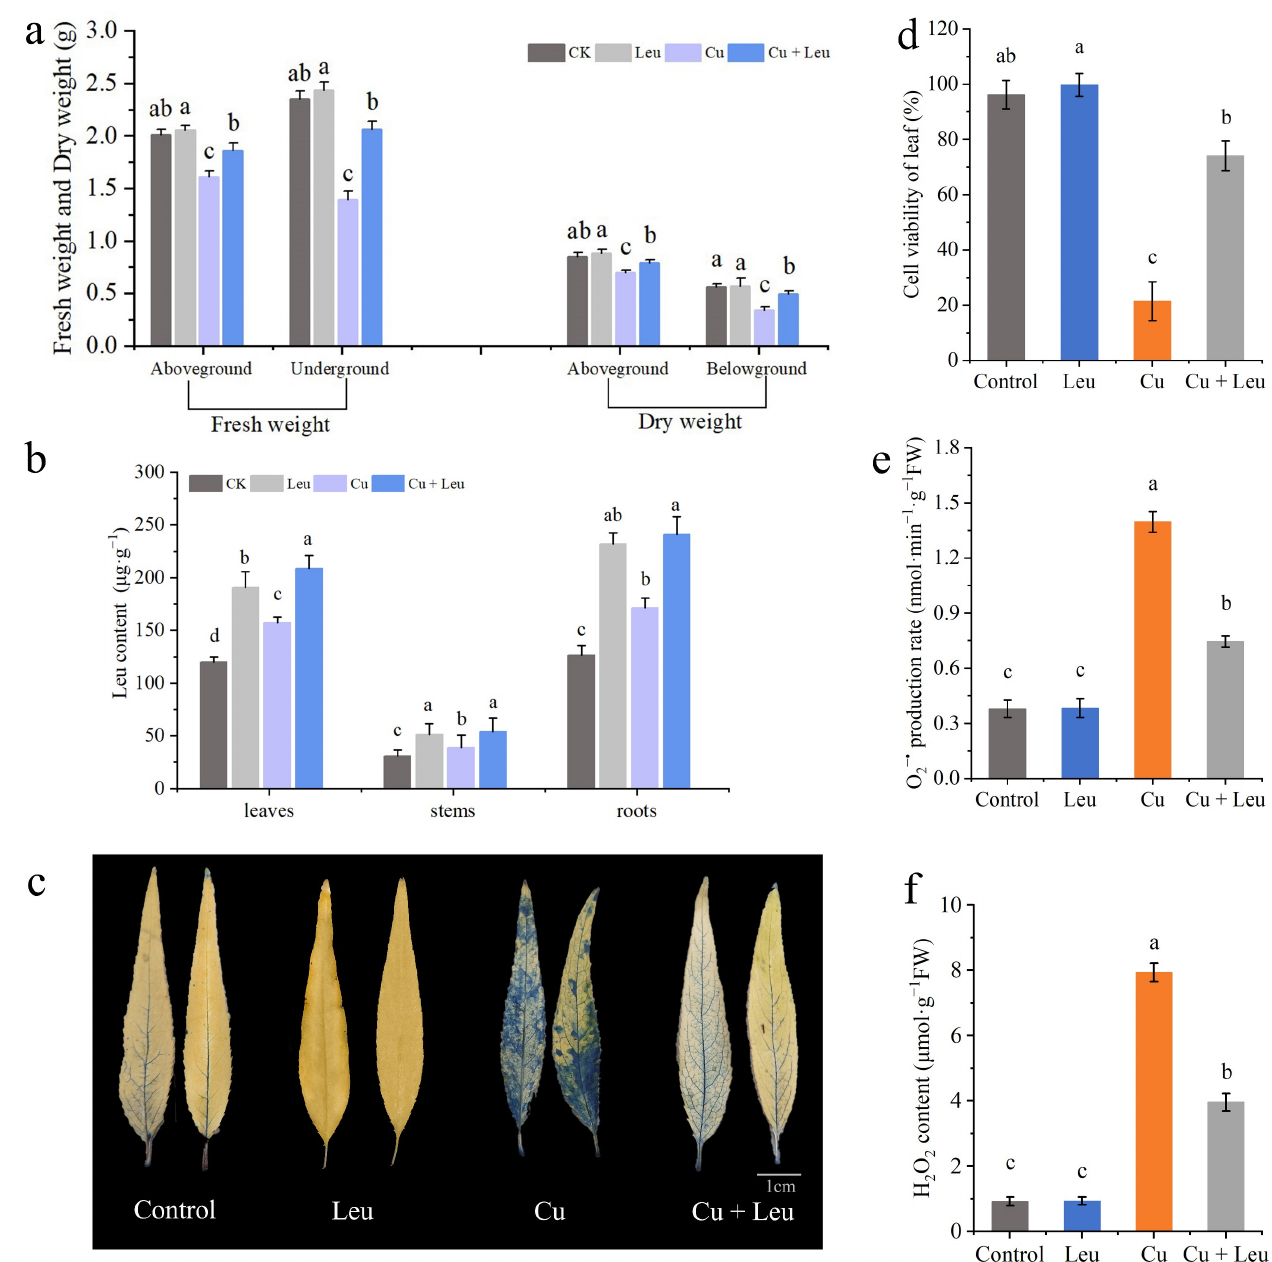
Figure 4. Effects of different treatments on biomass, leucine content, cell viability, and ROS accumula- tion in leaves of peach seedlings. ( a ) Fresh weight and dry weight of peach seedlings thirty days after the treatment; ( b ) leucine content; ( c ) Evans blue staining of leaves; ( d ) cell viability of leaves; ( e ) leaf O 2 •− production rate; ( f ) H 2 O 2 content. Error bars represent standard deviations of the means ( n = 3). Different lowercase letters indicate significant differences among different treatments (Duncan test, p < 0.05).